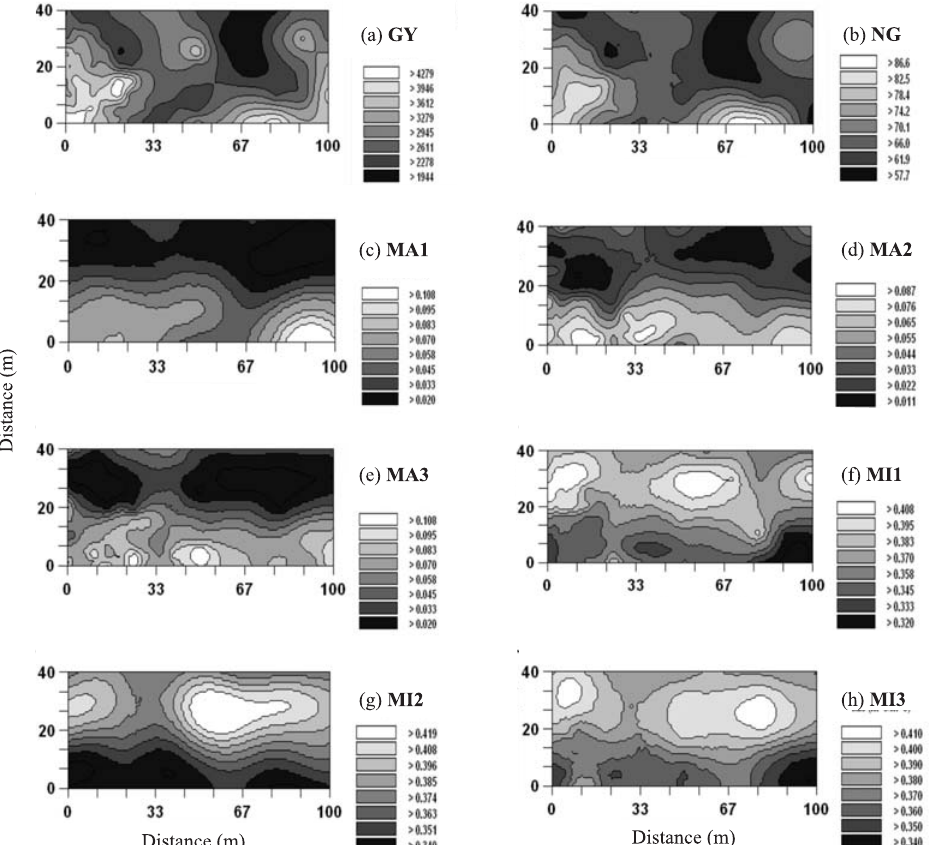
Figure 1. Kriging maps of soybean yield attributes macroporosity and microporosity of a dystroferric Red Latosol. GY: soybean grain yield; NG: number of grains per plant; MA and MI, from 1 to 3, respectively, are the macroporosity and microporosity of the evaluated soil